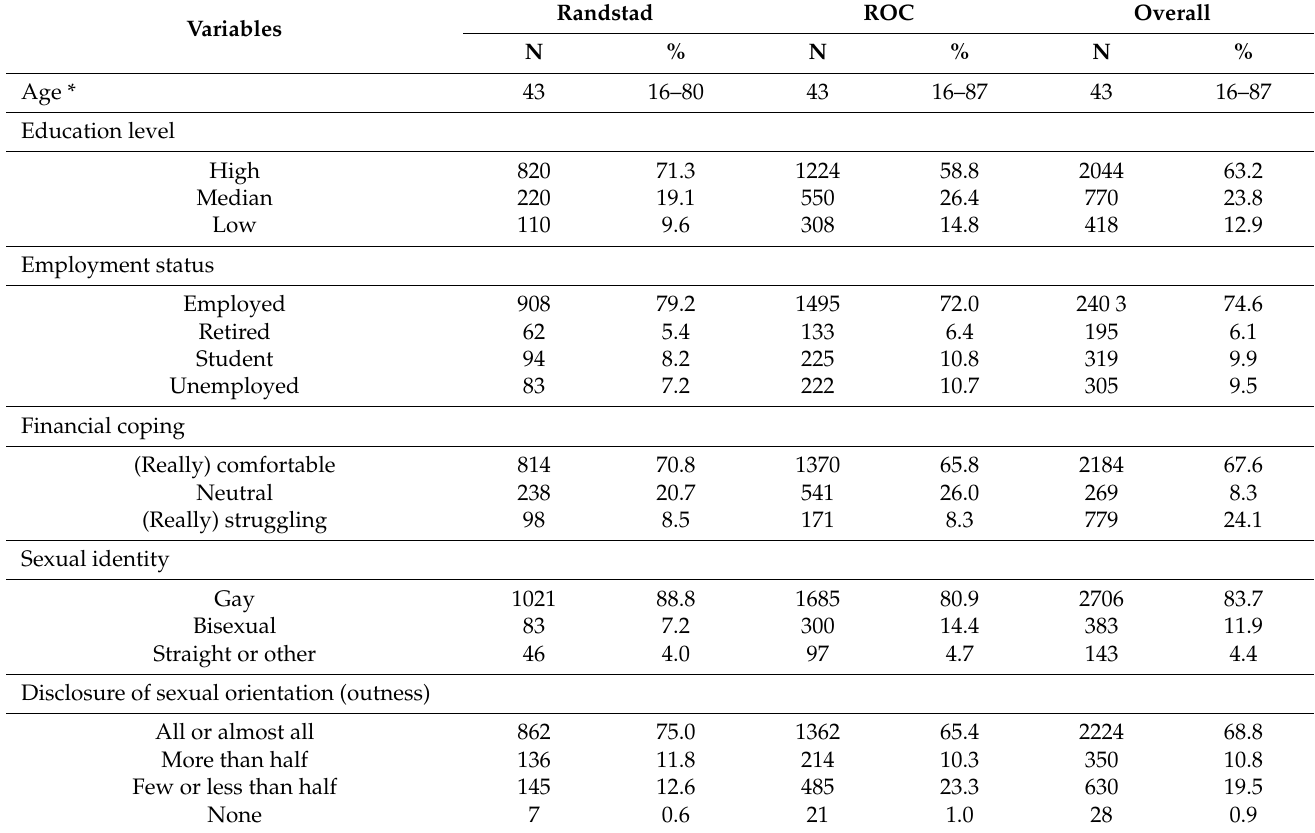
Table 1. Participant characteristics by